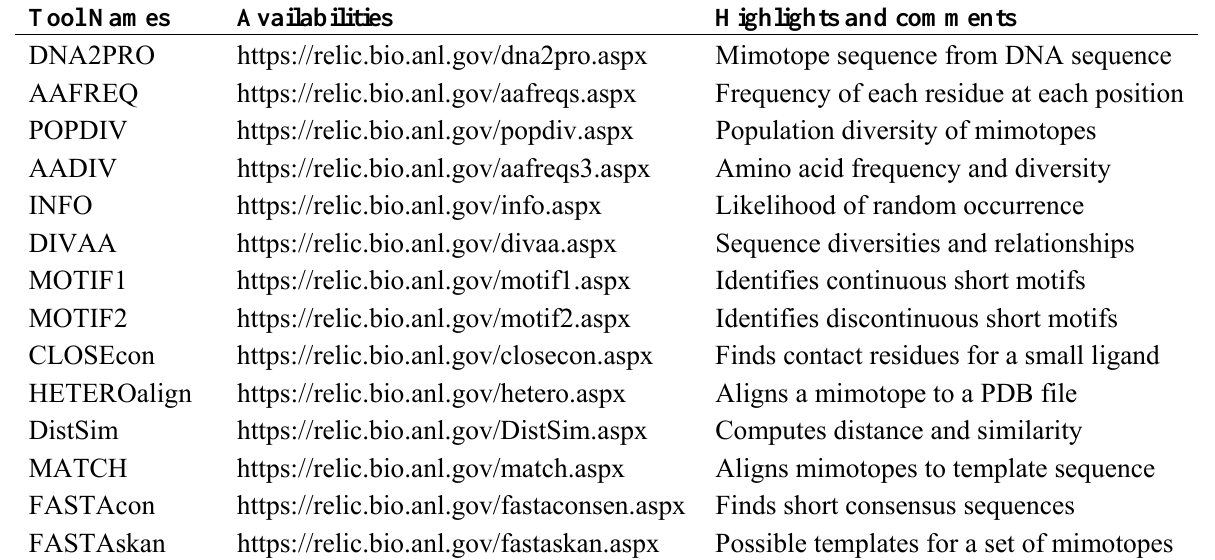
Table 3. Computational tools in the RELIC